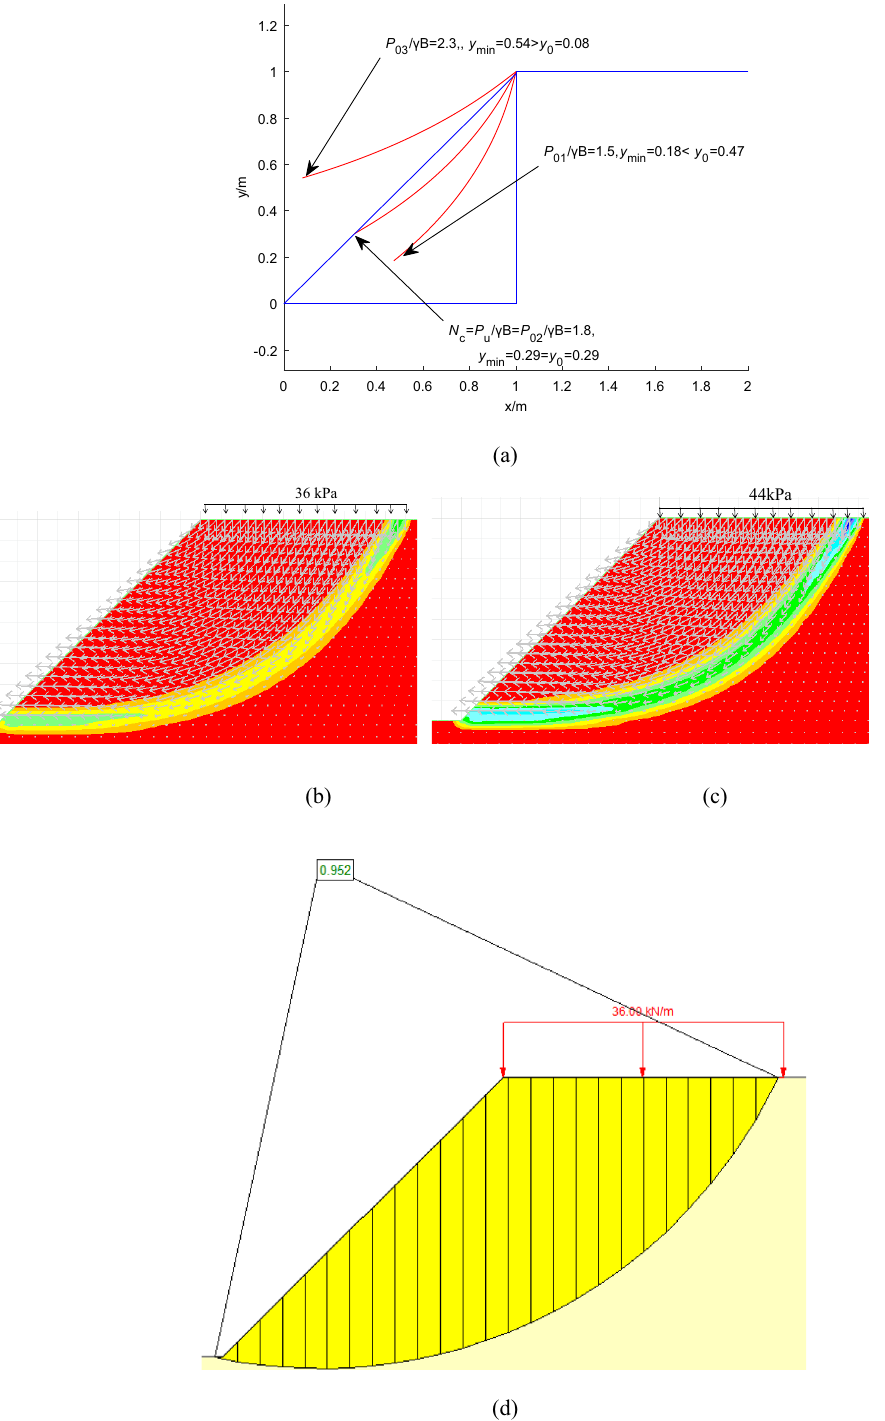
Figure 4. The case with c/γB = 0.6a and H/B = 1: ( a ) the proposed failure mechanism: N c = 1.8 (i.e., P u = 36 kPa); ( b ) the critical slip surface and FS = 0.96 using FLAC with 36 kPa; ( c ) the critical slip surface and FS = 0.85 using FLAC with 44 kPa; ( d ) the critical critical slip surface and FS = 0.95 using SLIDE with 36 kPa; ( e ) the critical critical slip surface and FS = 0.82 using SLIDE with 44 kPa; ( f ) the critical critical slip surface using FELA with 44